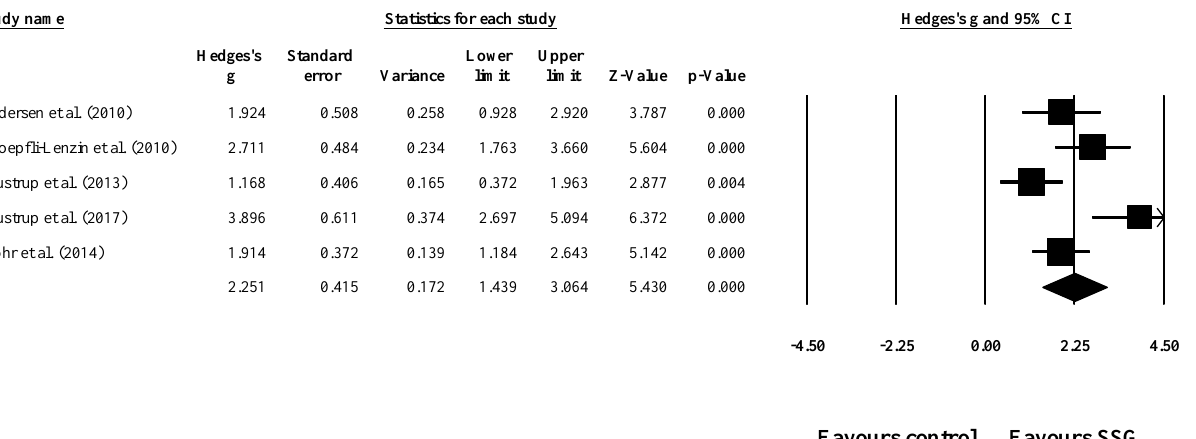
Figure 3. Forest plot of the changes in diastolic blood pressure after participating in small-sided games (SSGs) compared to the control condition. Values shown are effect sizes (Hedges’s g) with 95% confidence intervals (CI). The size of the plotted squares reflects the statistical weight of each study.